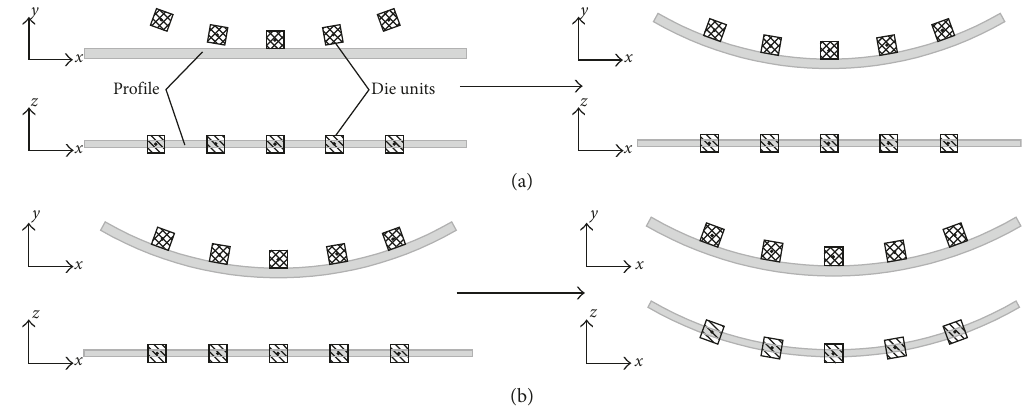
Figure 2: The 3D MPSB process. (a) Horizontal bending along the x - y plane. (b) Vertical bending along the x - z plane.